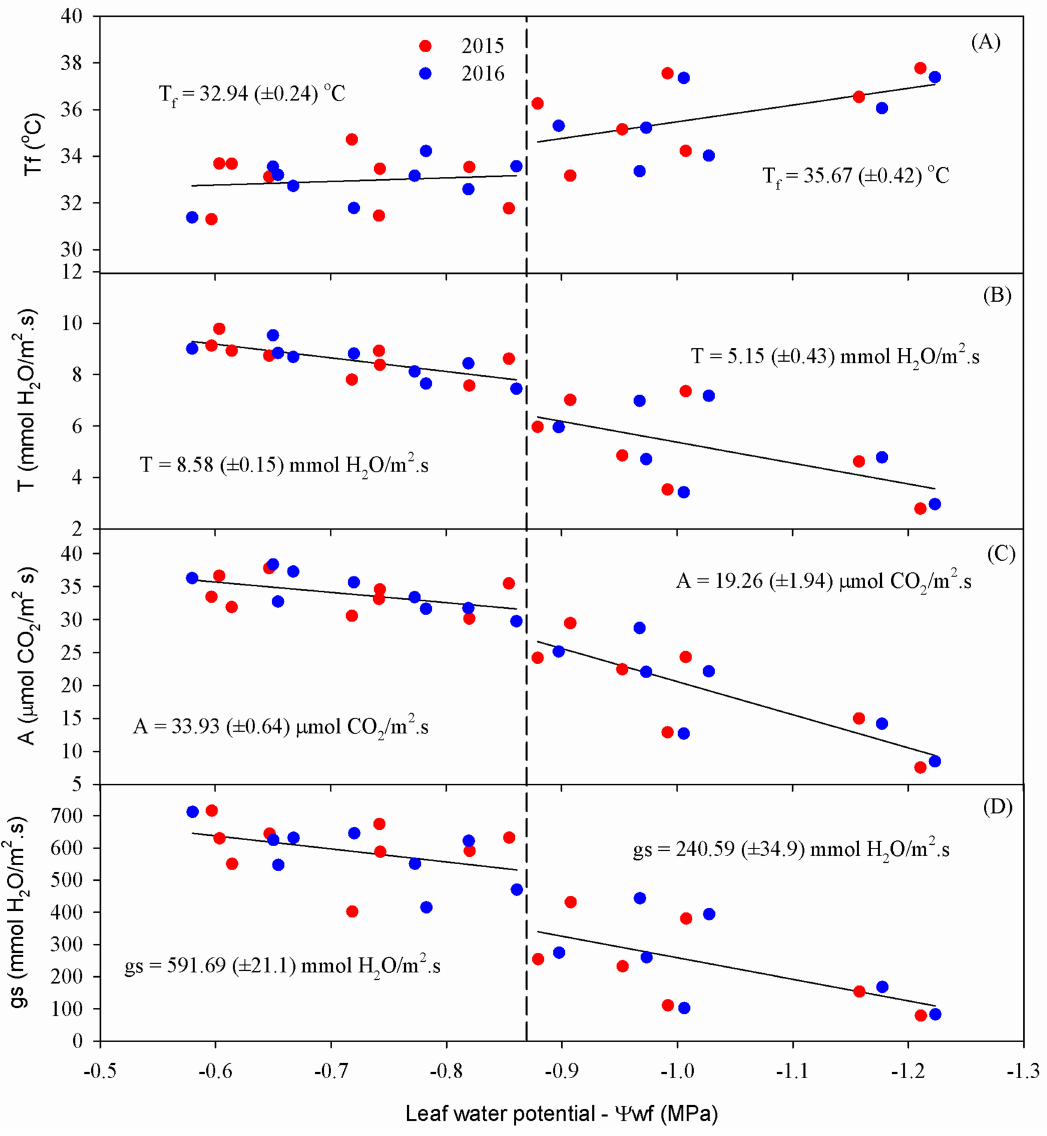
Figure 5. Leaf temperature— T leaf ( A ), leaf transpiration— E leaf ( B ), net photosynthetic rate— A ( C ) and stomatal conductance— gs ( D ) of cowpea plants according to the leaf water potential ( Ψ w ) in the 2015 (red) and 2016 (blue) experiments, Castanhal, Par á